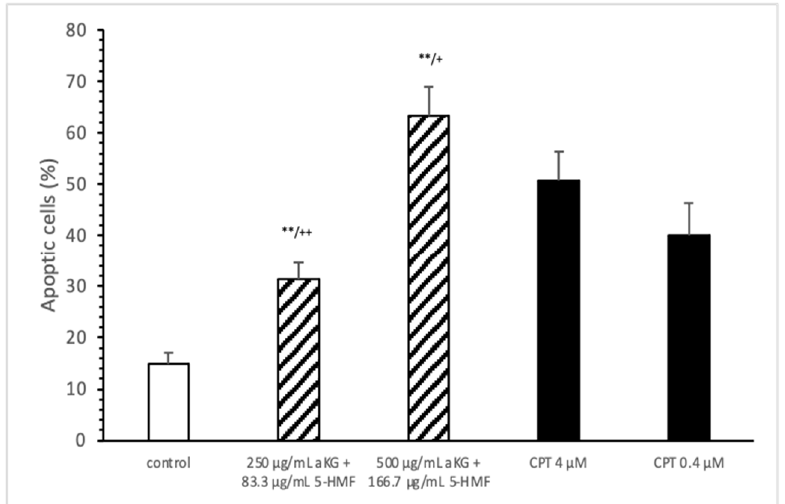
Figure 5. Estimation of apoptotic cells (JC-1) of the Jurkat cell lines after 72 h of cell growth using a combined solutions of 250 µg/mL aKG + 83.3 µg/mL 5-HMF, 500 µg/mL aKG + 166.7 µg/mL 5-HMF, and 4 µM or 0.4 µM CPT as positive controls ( n = 3). ** p < 0.001: significance between the control and combined solutions of aKG + 5-HMF. + p < 0.01: significance between the positive control (4 µM CPT) and combined solutions of aKG + 5-HMF. ++ p < 0.001: significance between the positive control (4 µM CPT) and combined solutions of aKG + 5-HMF.